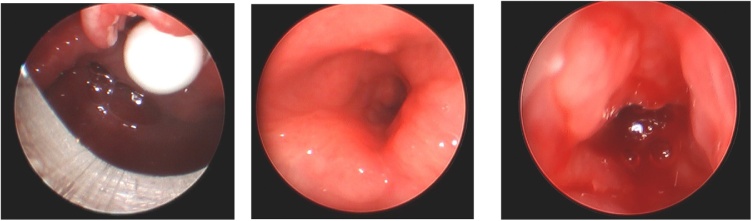
Images - Direct Microlaryngoscopy and Rigid Bronchoscopy.